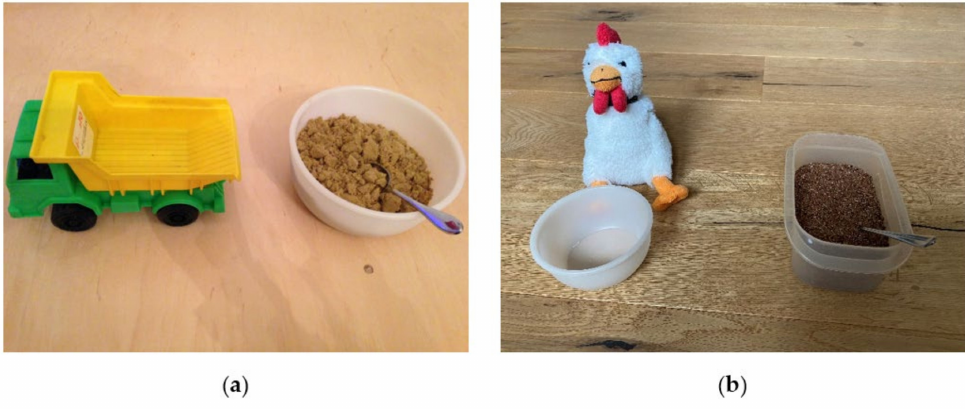
Figure 2. Pictures of the experimental setting of the SFON tasks with one numerosity: ( a ) truck task at Time 1; ( b ) chicken task at Time